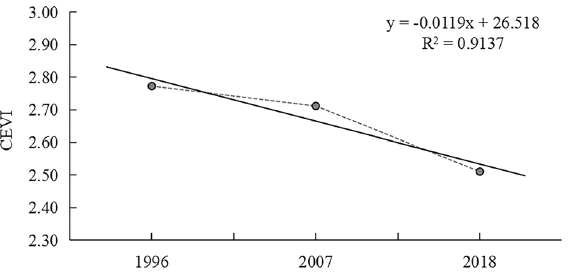
Figure 6. Annual change of the comprehensive ecological vulnerability index. CEVI, comprehensive ecological vulnerability index.